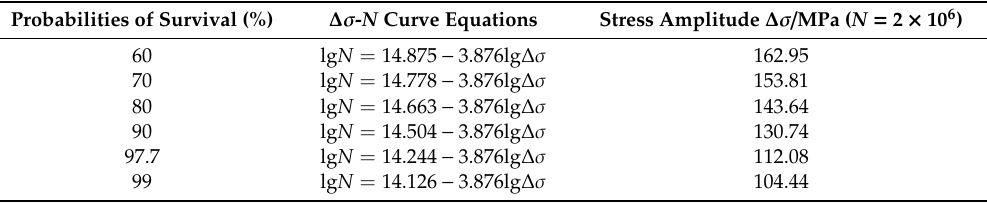
Table 5. ∆ σ - N curve equations and stress amplitude for di ff erent failure